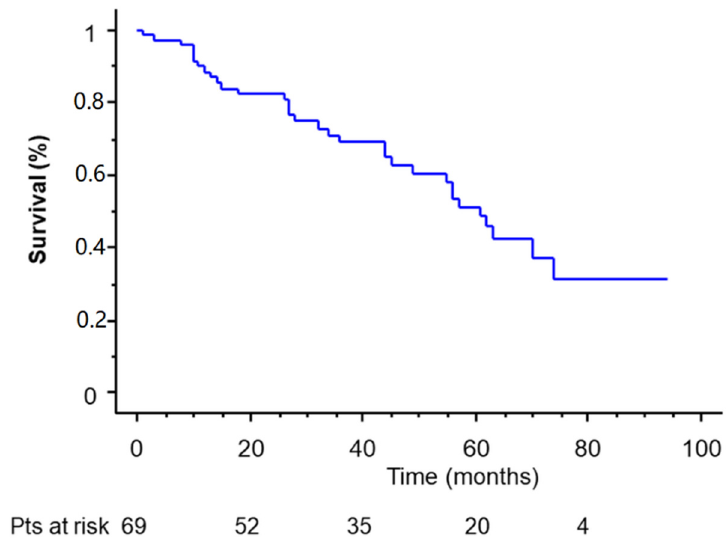
Figure 2. Overall survival of the entire population who underwent completion pneumonectomy. The overall 5-year survival for the IT group was 69.8% compared with 39.2% for the no-IT group ( p = 0.01) (Figure 3).